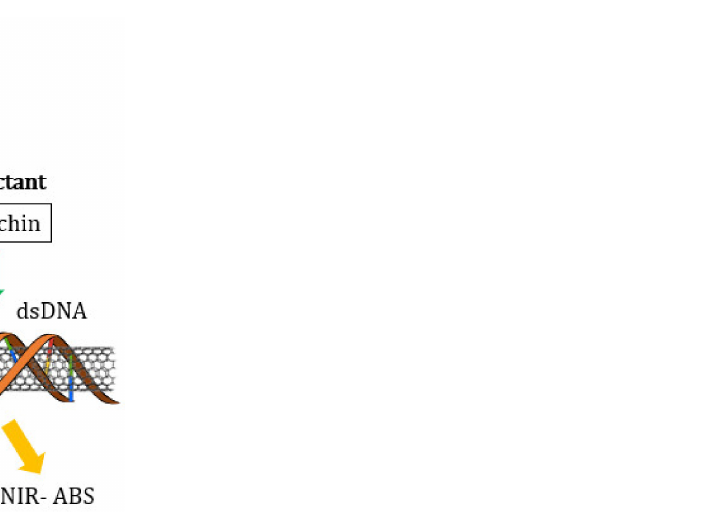
Figure 1. Conceptual diagram of experiment.